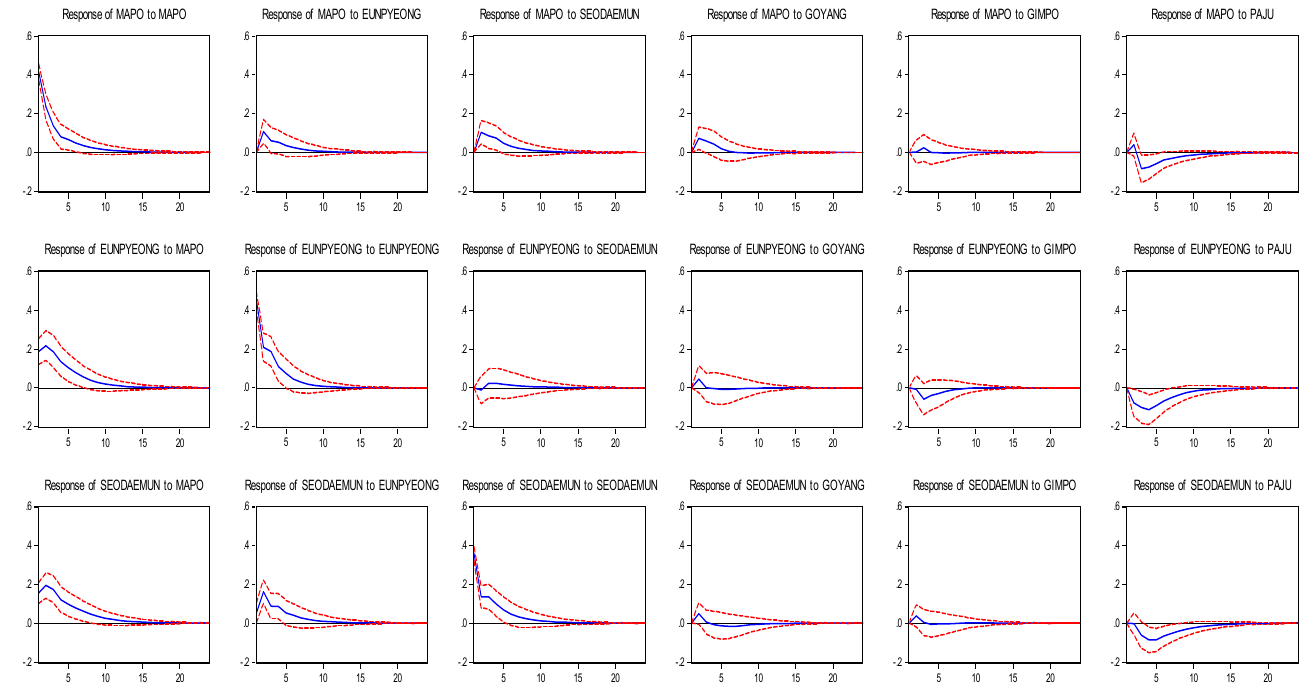
Figure 3. Impulse response analysis of the jeonse market in the Northwest region.